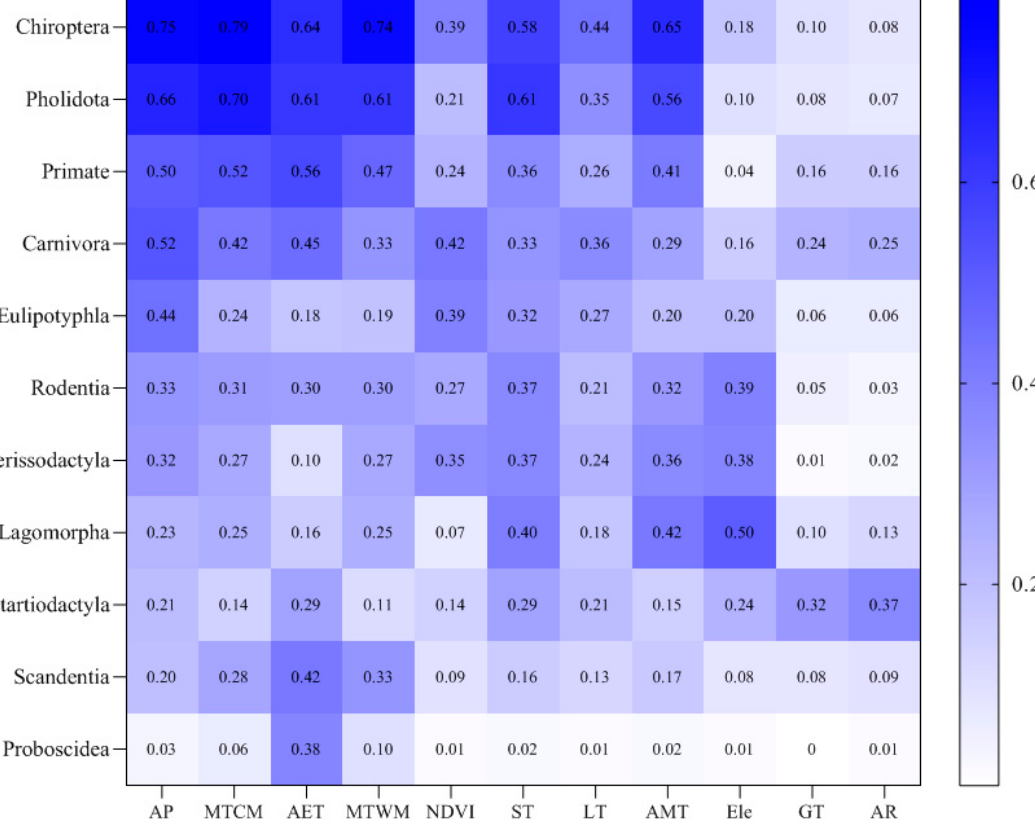
Figure 4. Influence of environmental factors on the richness distribution of mammalian orders (q values).